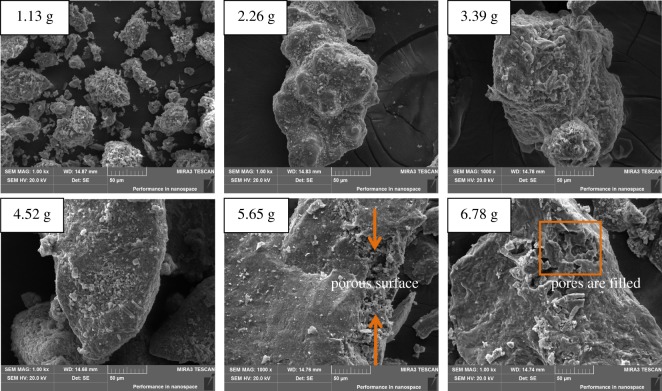
SEM images of samples with different amounts of Na2CO3.